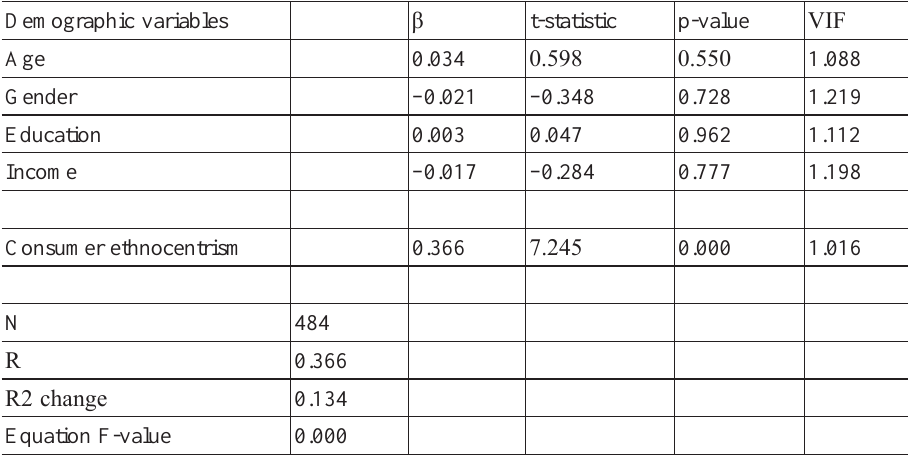
Table 3. Influence of demographic variables and consumer ethnocentrism on intention to purchase domestically produce